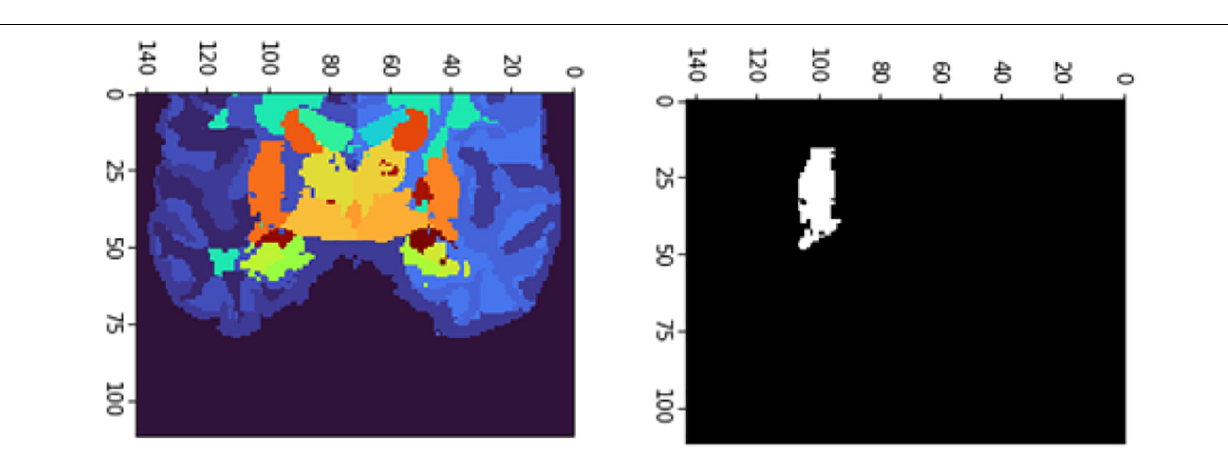
FIGURE 9 | 2D scan from the output volume of subject OAS30319_MR_d0043. We have chosen the third ventricle of the brain structure with an intensity value of 26.